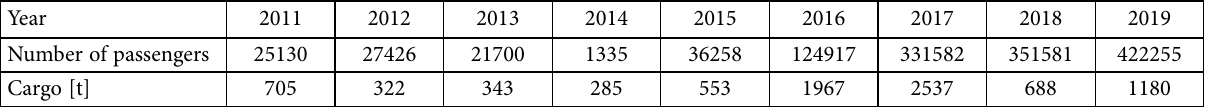
Table 1. Number of passengers and cargo statistics of “Constantine the Great” airport (NCGA